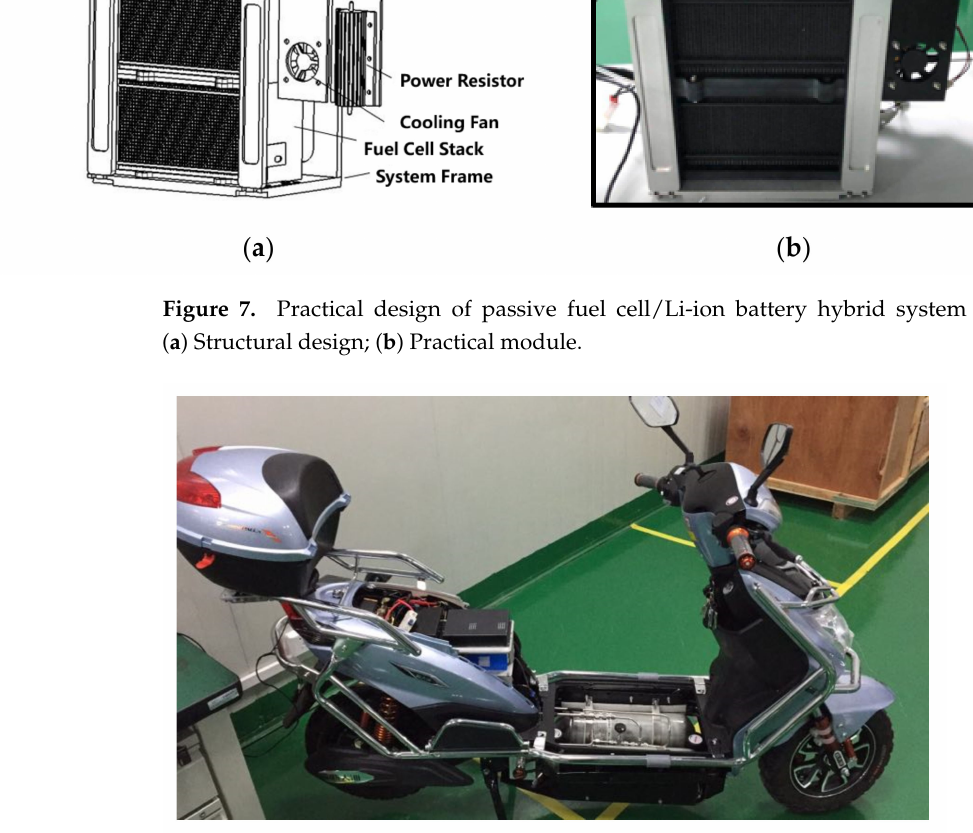
Figure 8. The e-scooter equipped with the passive fuel cell/Li-ion battery hybrid